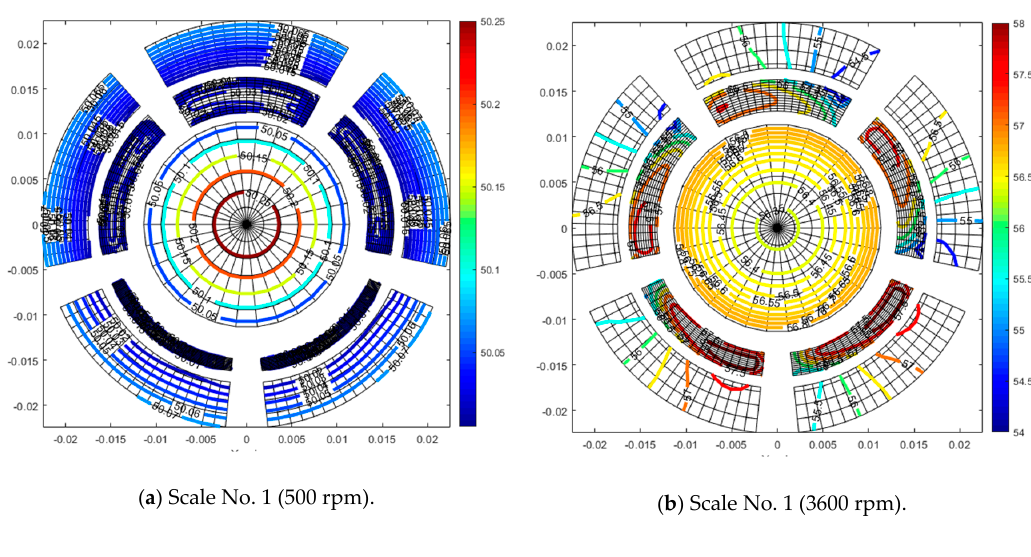
Figure 7. Thermal characteristics.